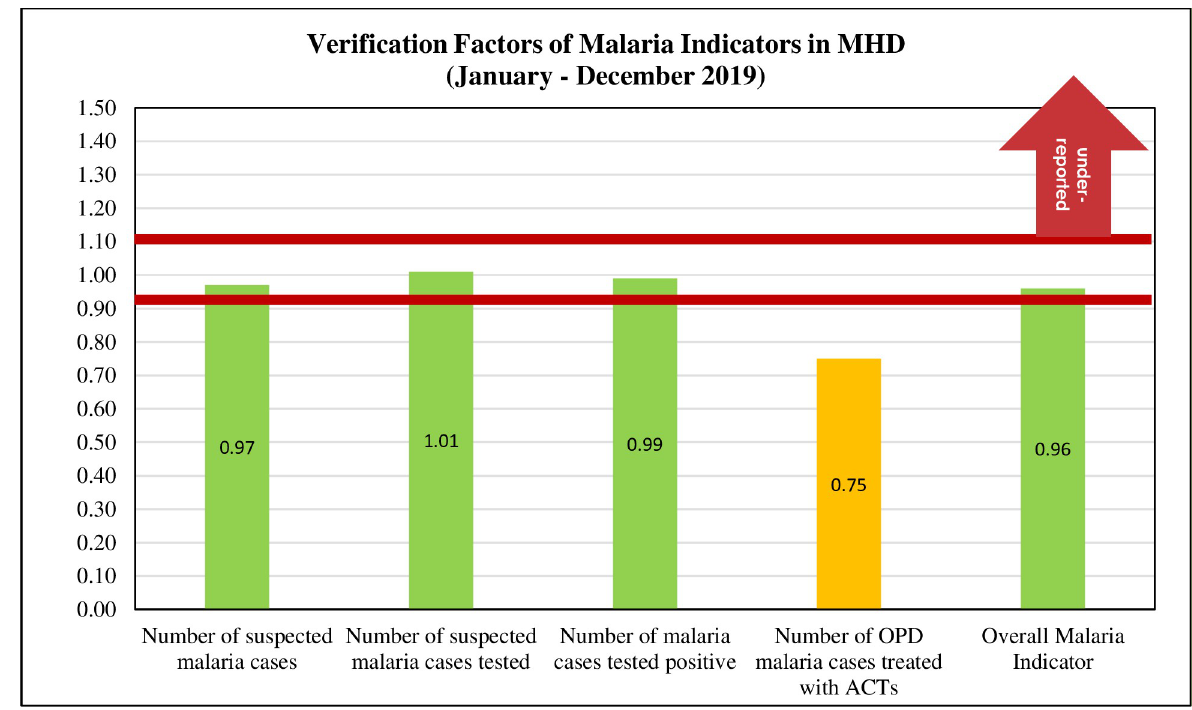
Fig 4. Verification factors of malaria indicators. Source: Survey,